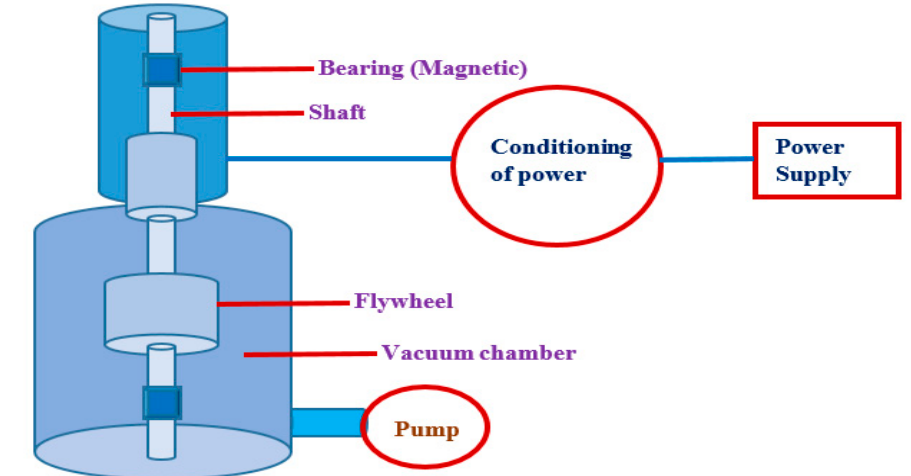
Figure 4. Flywheel energy storage system schematic.